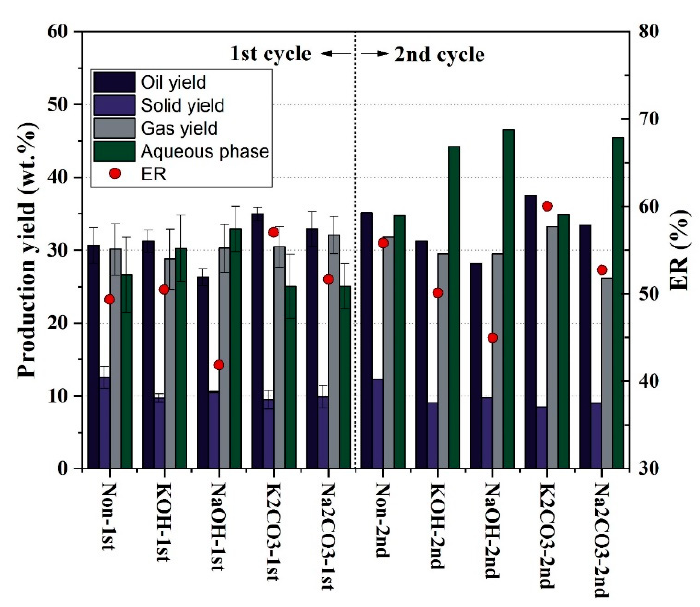
Figure 1. Distribution of HTL products and ER of bio-crude.